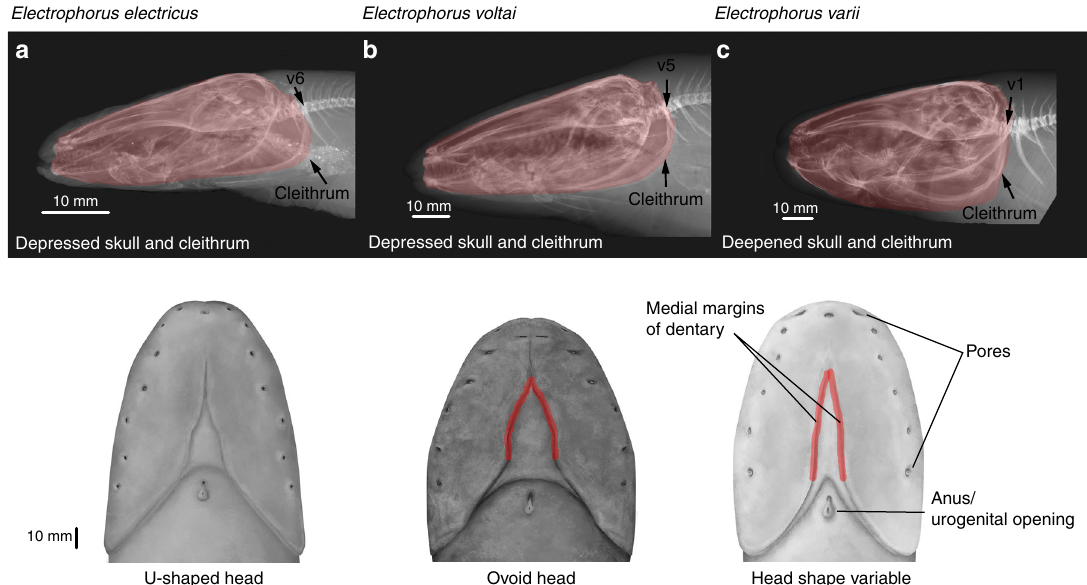
Fig. 2 Key morphological features to recognize the three species of Electrophorus . Top, radiographs of lateral view of the anterior portion of body (skull and pectoral girdle highlighted red). The cleithrum lies between the fi fth and sixth vertebrae (v) in Electrophorus electricus ( a ) and E . voltai ( b ) versus fi rst and second vertebrae in E . varii ( c ). Bottom, illustrations of ventral view of the head, showing key features listed in Diagnoses. a top: National Museum of Natural History, NMNH 403765, 300 mm TL, Cuyuni River, Guyana; bottom: NMNH 225576, 1000mm TL, Corantijn River, Suriname. b top: Instituto Nacional de Pesquisas de Amazônia, INPA 39009, 450 mm TL, Teles Pires River, Brazil; bottom: Academy of Natural Sciences of Drexel University, ANSP 197583 (t3539), 1280mm TL, Xingu River, Brazil. c top: NMNH 306677, 450 mm TL, Lago Janauari, Amazon River, Brazil; bottom: NMNH 196634,